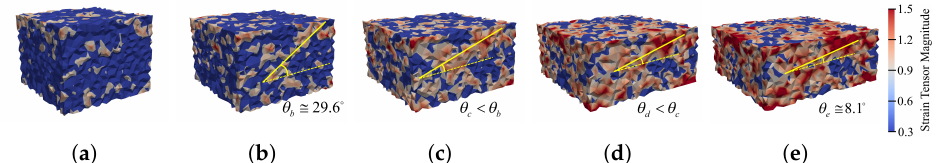
Figure 13. The micro-strain contour evolution during the compaction process of specimen S 5 , ( a ) (cid:101) 3 = 0.1, ( b ) (cid:101) 3 = 0.2, ( c ) (cid:101) 3 = 0.3, ( d ) (cid:101) 3 = 0.4, ( e ) (cid:101) 3 =